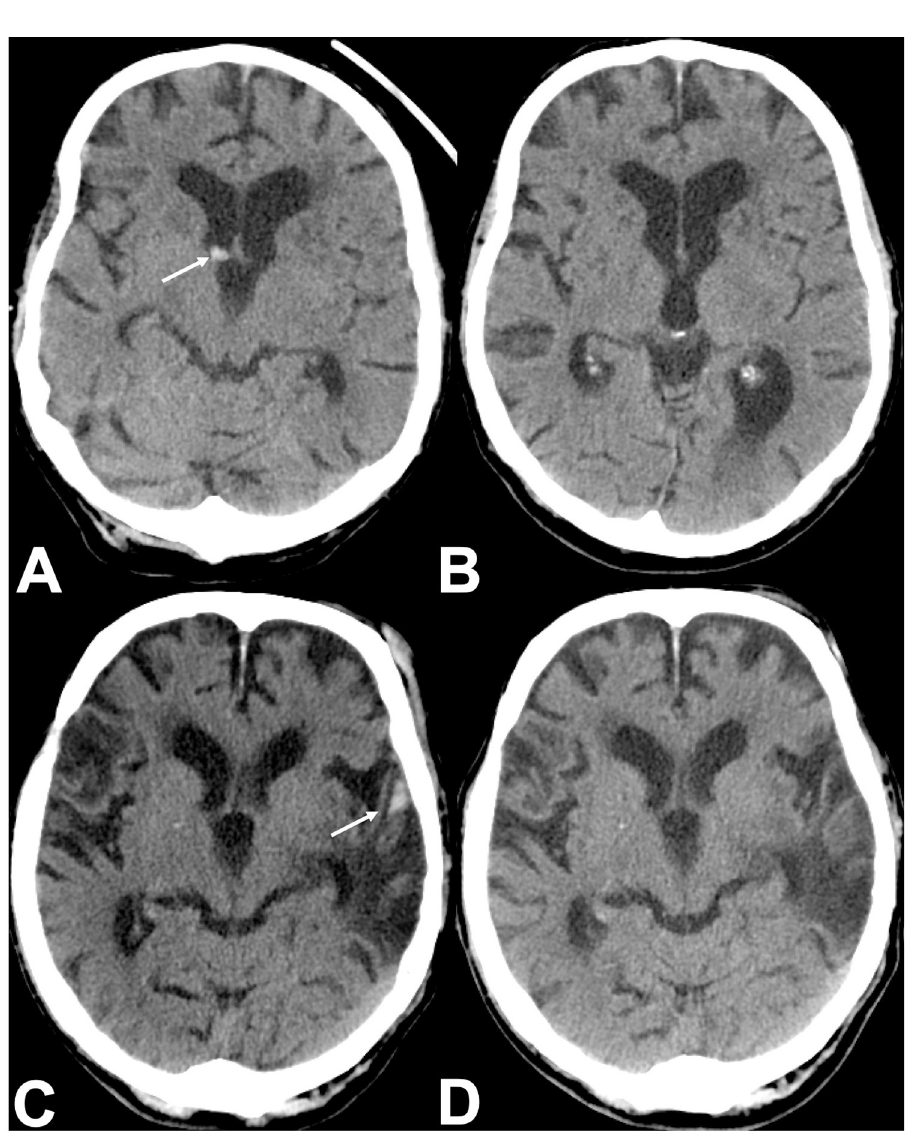
Fig 5. ICHs missed by the algorithm compared to previous imaging. Axial HCT showing ICHs (white arrows) missed by the AI algorithm in the right ventricle (A) and the left temporal lobe after ischemic stroke (C). B and D show the corresponding HCTs acquired during the same year, differentiating these hyperdensities from calcifications (HCT, head computed tomography; ICH, intracranial hemorrhage; AI, artificial intelligence).